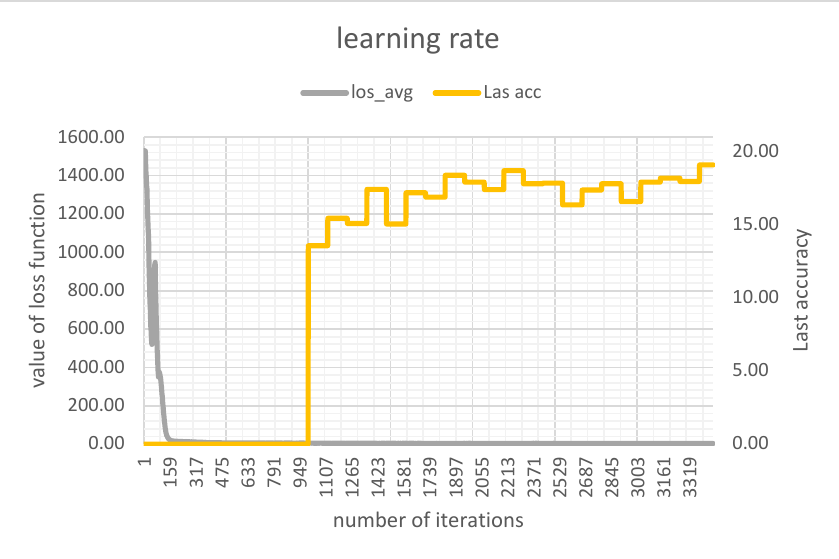
Figure 5. Model training process